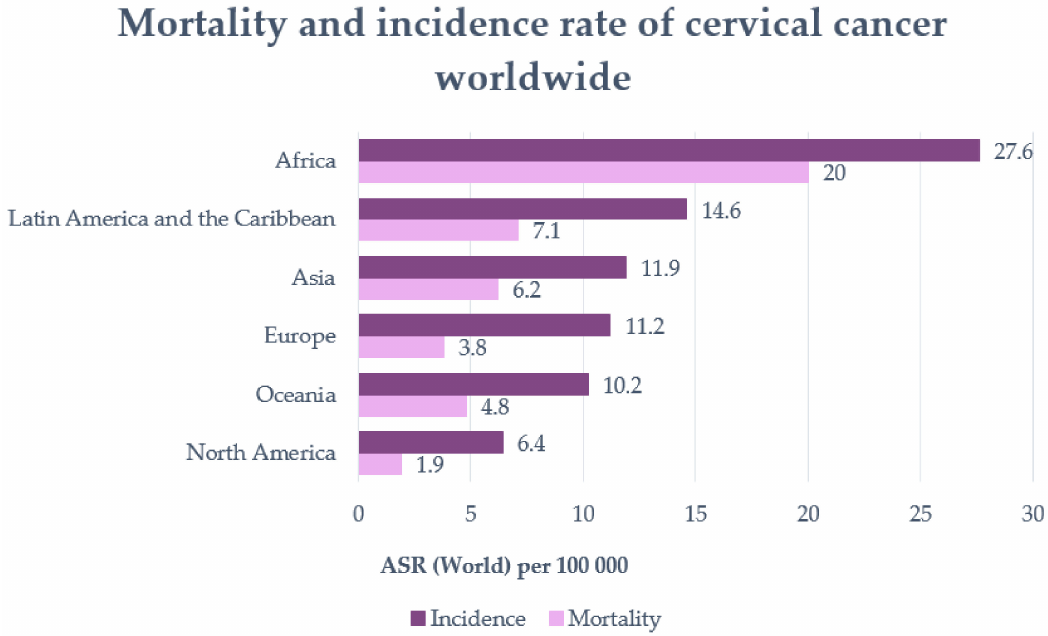
Figure 1. Mortality and incidence rate of cervical cancer worldwide (per 100,000 individuals) (adapted after Khazaei et al., 2019 [2]).